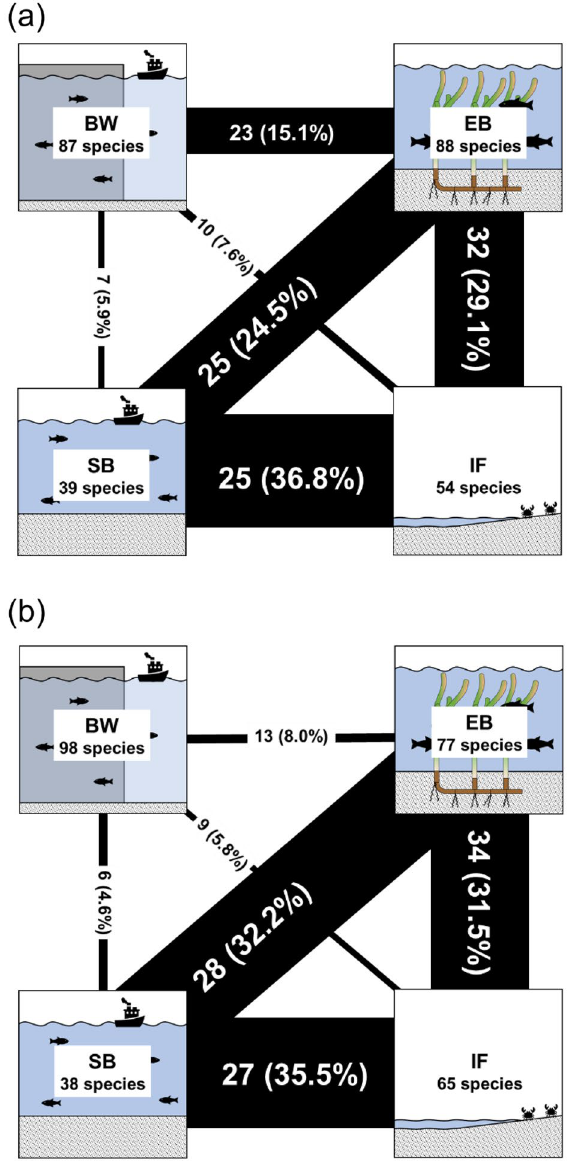
Figure 3. Shared species in habitat pairs. Panels show data for ( a ) summer and ( b ) winter. Black numbers in each box indicate total numbers of species collected in each habitat. White or black numbers on the black lines indicate the numbers of species that were shared between each habitat pair with percentages based on Jaccard indices shown in parentheses. The thickness of each black line is proportional to the percentage of species shared. Habitat abbreviations are as shown in Fig.